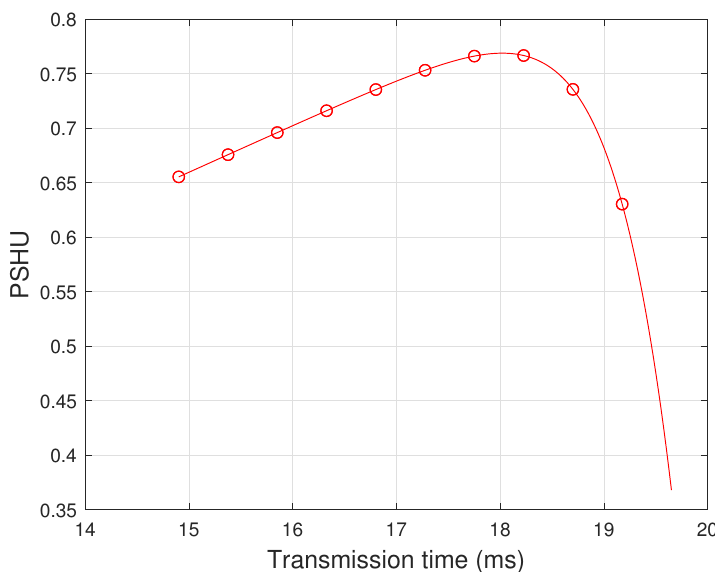
Figure 5. Probability of spectrum hole utilization (PSHU) vs. tranmission time ( T tr ) of SUs.